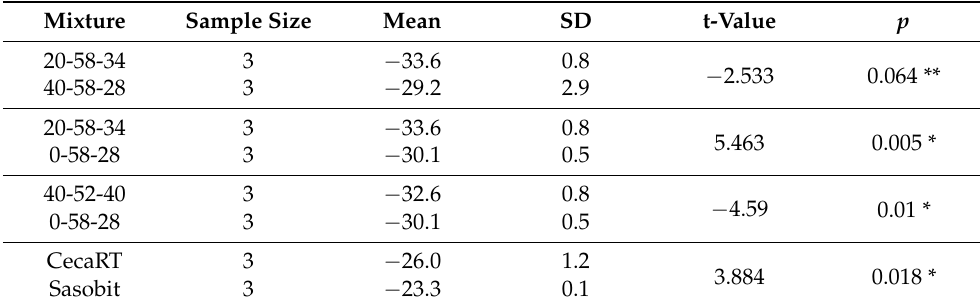
Table 4. Statistical results of CCT between asphalt